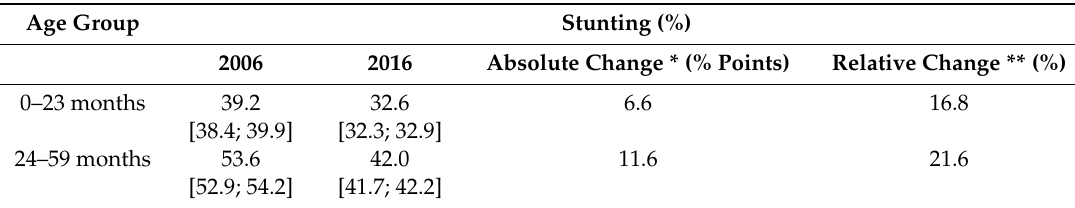
Table A2. Prevalence of anthropometric failures among children by Age groups, India, NFHS 2006 and 2016.